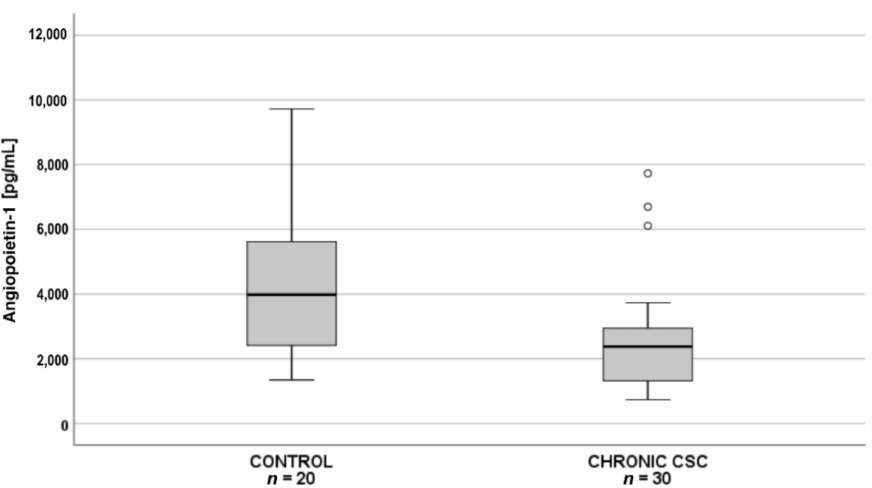
Figure 3. Box-and-whisker plot of plasma angiopoietin-1 levels in patients with chronic central serous chorioretinopathy and controls ( p = 0.007; X 2 (2) = 9.656; post hoc test statistics = 20.3). The line inside the box represents the median; the lower and upper sides of the box represent the lower and upper quartiles, respectively. Whiskers represent cases distant up to 1.5 of interquartile range (IQR) from the respective quartile; circles, cases distant from 1.5 to 3 IQRs. p values were estimated using the post-hoc pairwise comparison for the Kruskal–Wallis test with Bonferroni correction. Additionally, we performed an analysis for the whole CSC group (patients with both chronic and acute form, n = 60) vs. controls ( n = 20). Plasma VEGF, PDGF-AA, and PlGF levels in patients with acute or chronic CSC ( n = 60) were significantly lower than in the controls (Figure